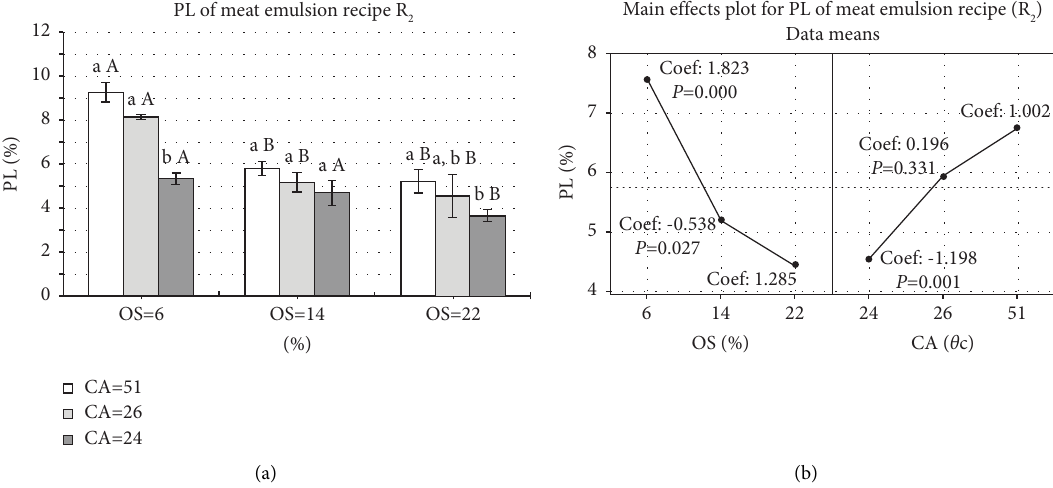
Figure 4: (a) Purge losses (PL) of stufed samples with meat emulsion recipe R2 (TEF: 17.7 ± 1.48%). Diferent lowercase letters indicate a signifcant diference ( P < 0.05) among casings with diferent CA (contact angle) and diferent capital letters indicate a signifcant diference among casings with diferent OS (overstufng). (b) Main efects plot for PL in meat emulsion recipe R 2 . Coefcients and P -valor included in the fgure were taken of the general lineal model analyze (ANOVA). By default, minitab make comparisons with respect of extreme level of each factor (OS � 22%; CA: 51 θ